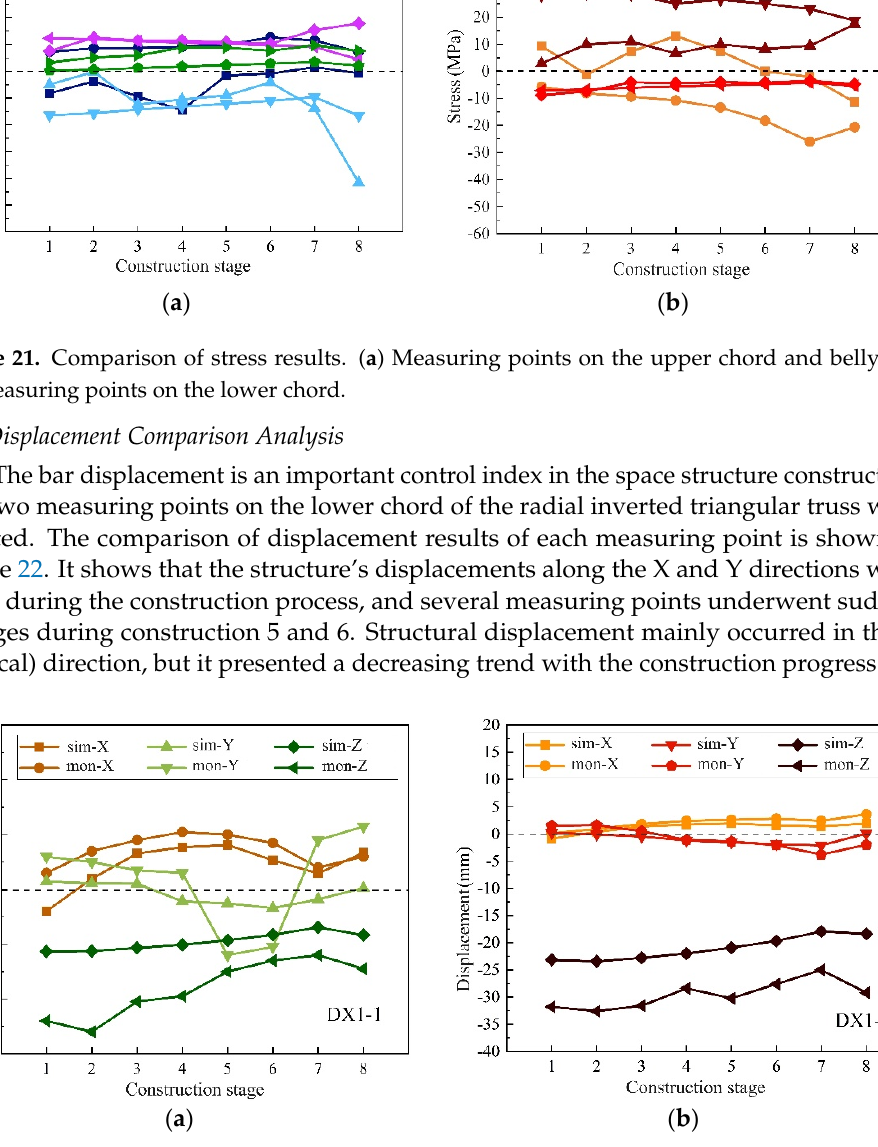
Figure 22. Comparison of displacement results. ( a ) DX1-1, ( b ) DX1-2.